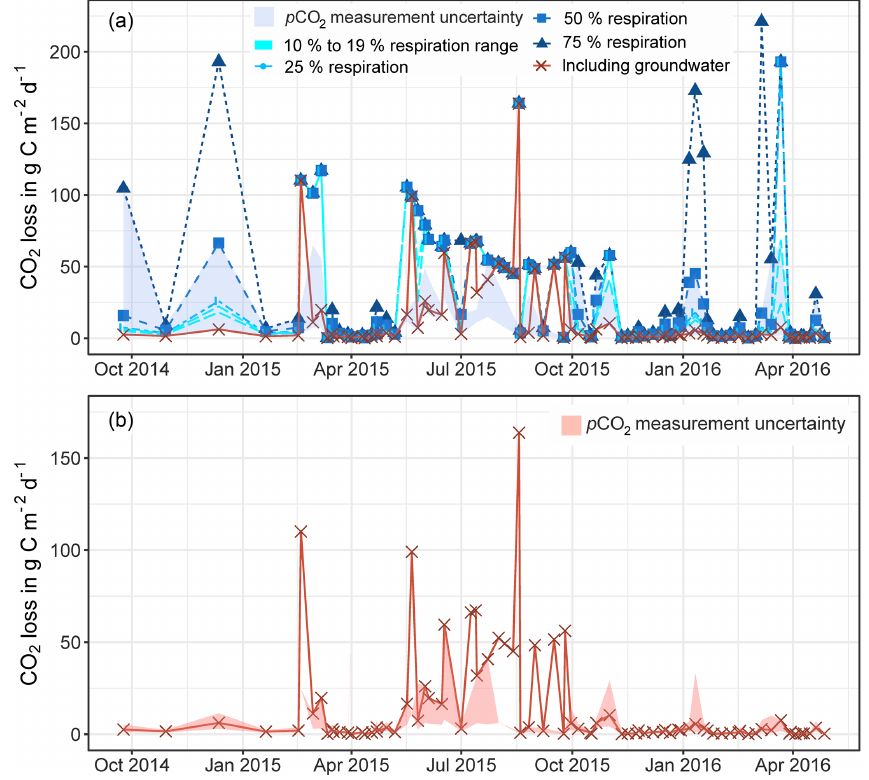
Figure 3. Modelled carbon dioxide loss via outgassing from the stream to the atmosphere upstream of the Uhlíˇrská catchment outlet (UHL) based on the model by Polsenaere and Abril (2012) for proportion river respiration ( R ) between 10 and 75% (a) and modified with measured groundwater δ 13 C DIC (a, b) . The areas shaded in blue (a) and red (b) indicate uncertainties in calculation of p CO 2 with ± 21%. Convergence criteria were not fulfilled for data points that lie outside the shaded area (see Sect.